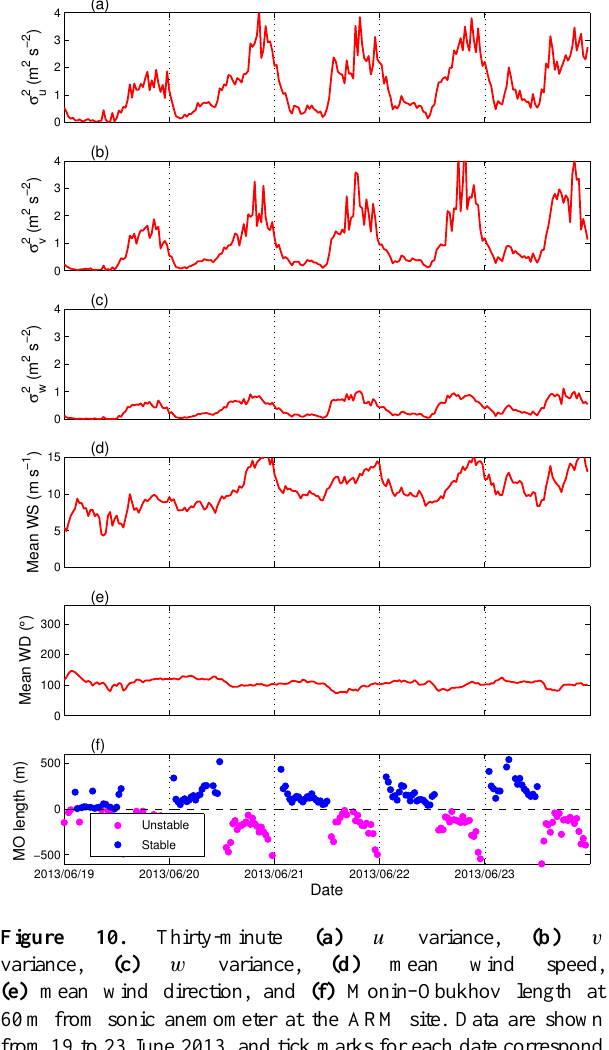
Figure 10. Thirty-minute (a) u variance, (b) v variance, (c) w variance, (d) mean wind speed, (e) mean wind direction, and (f) Monin–Obukhov length at 60m from sonic anemometer at the ARM site. Data are shown from 19 to 23 June 2013, and tick marks for each date correspond to 00:00UTC on that